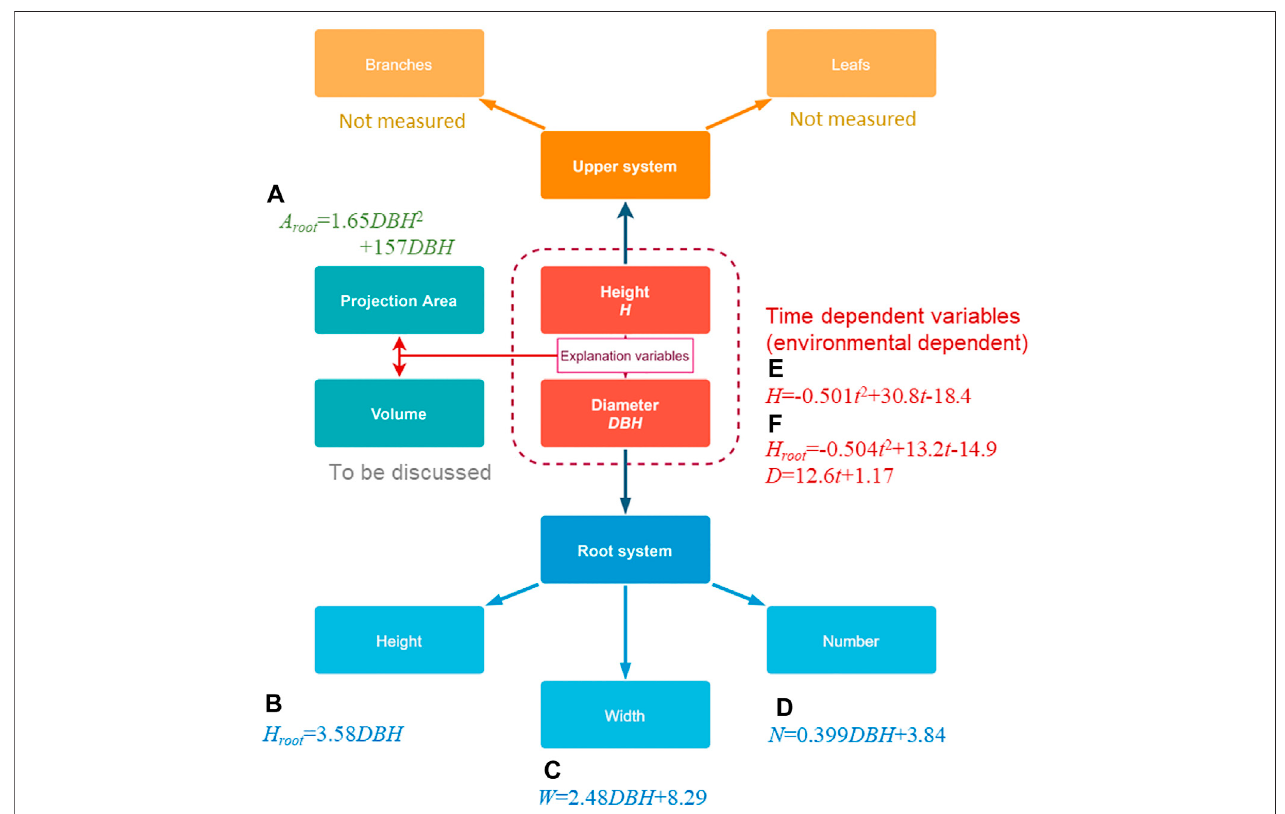
FIGURE 7 | Summary of the geometric characteristics of mangroves ( Rhizophora stylosa